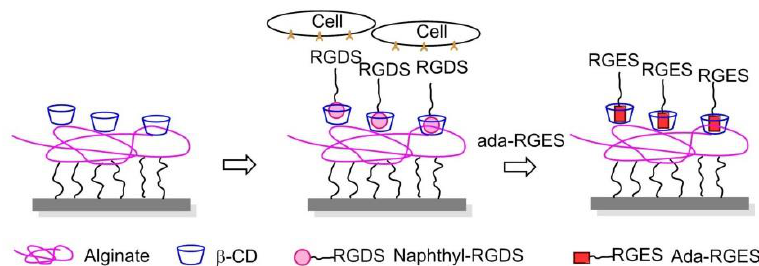
Figure 22. Dynamically competitive polymers. Guest molecular naphthyl-RGDS is captured by β-CD, which is grafted on alginate. Cell adhesion and spreading can be controlled dynamically because the addition of Ada-RGES can reverse cell adhesion due to it competed with naphthyl-RGDS to form a complex with β-CD.